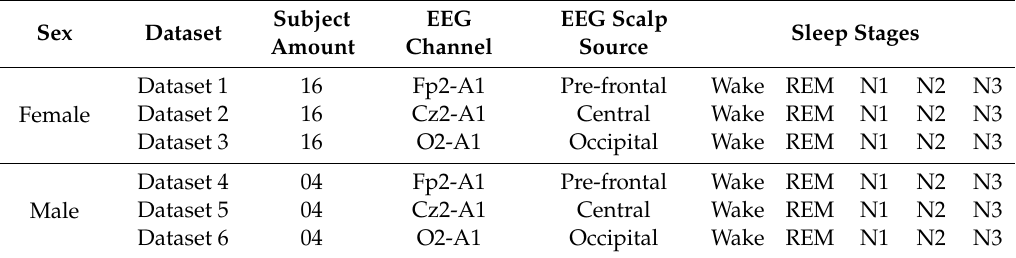
Table 1. Details of considered dataset.